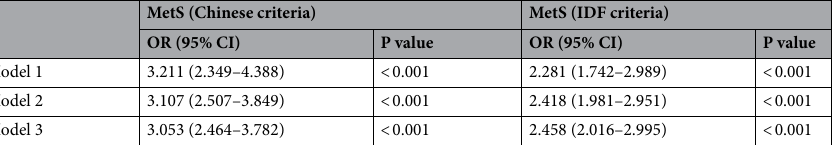
Table 3. Association between the THR and MetS according to models with different risk factors. Model 1: not adjusted. Model 2: adjusted for sex. BMI, hyperurecemia and eGFR. Model 3: adjusted for sex, age, BMI, hyperurecemia and eGFR, current smoking, current drinking and physical activity. BMI body mass index, CI conference interval, eGFR estimated glomerular filtration rate, IDF international diabetes federation, MetS metabolic syndrome, OR odds ratio, THR total and high density lipoprotein cholesterol